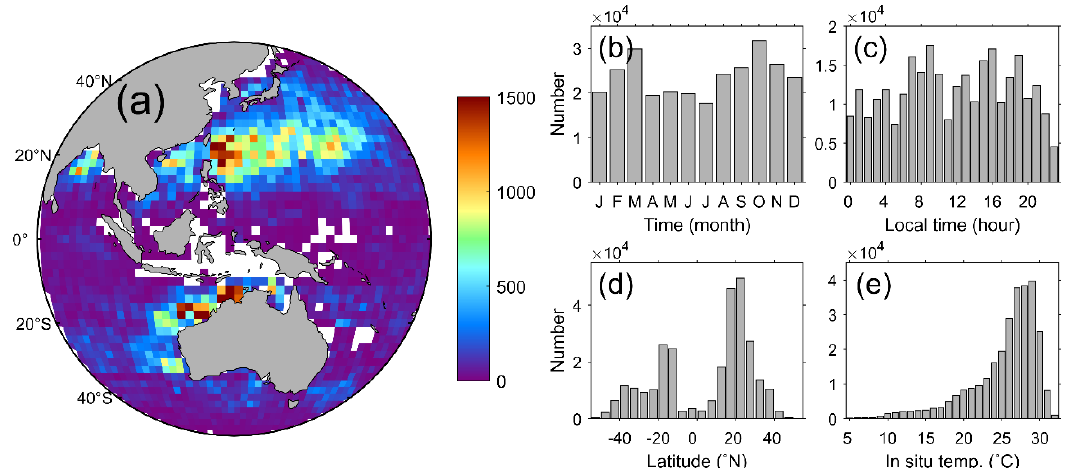
Figure 3. ( a ) Spatial distribution of the number of matchup points between COMS and in situ measurements in bins of 2° × 2° and the histograms of the matchups with respect to ( b ) month, ( c ) local time (hour), ( d ) latitude (°N), and ( e ) in situ temperature (°C) for the period from April 2011 to March 2015.